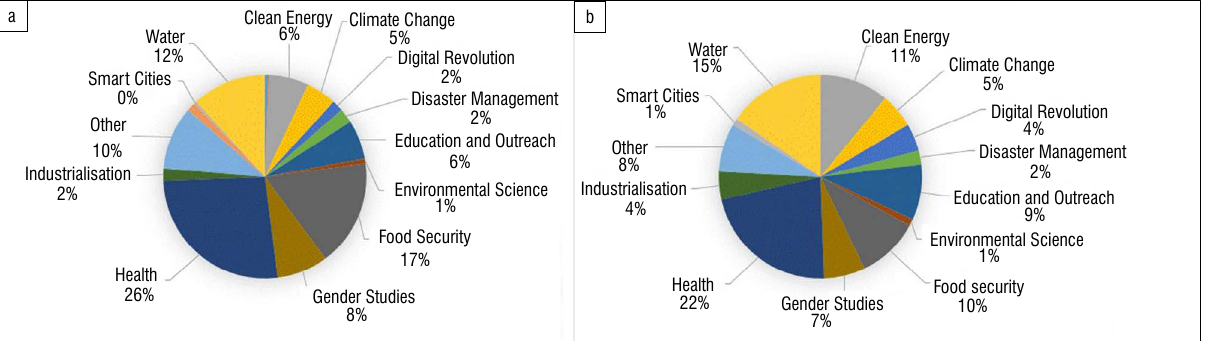
Figure 3: Themes represented by (a) African-Arabian and (b) South African submissions.